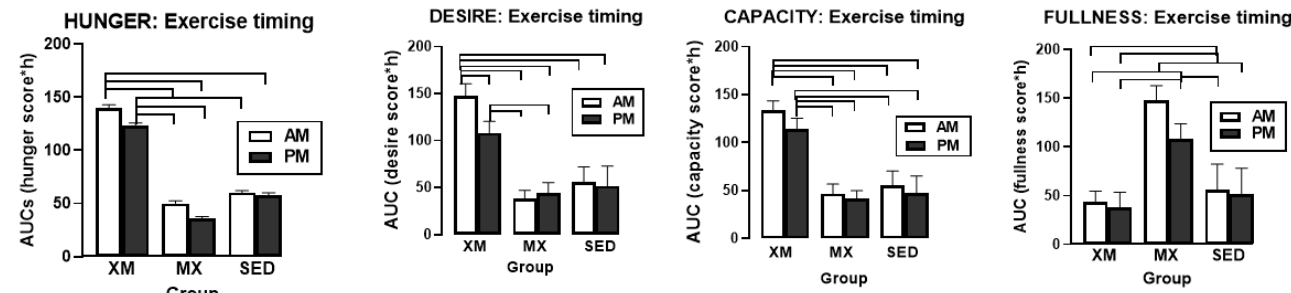
Figure 10. Exercise- and meal-timing effects on the VAS appetite score AUCs. Brackets identify groups with significant between- and within-group differences. Morning and evening XM hunger, desire, and capacity AUCs were significantly higher than MX and SED AUCs. Morning and afternoon MX AUCs were significantly higher than XM and SED AUCs. EX = exercise, XM = exercise before meals, MX = exercise after meals, SED = sedentary group.